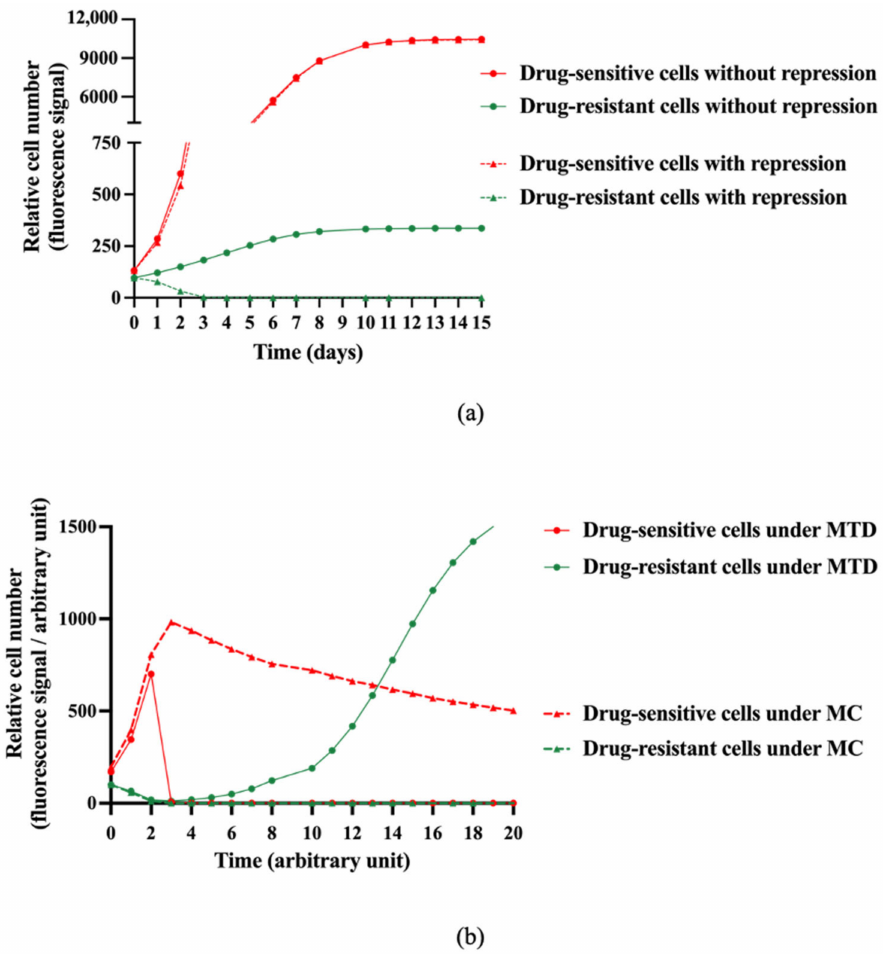
Figure 2. Model-based in silico simulation of the interaction between sensitive and resistant clones with or without treatment. ( a ) Model-based in silico simulations of relative drug-sensitive and drug-resistant cell proliferation over time with or without a repressive effect exerted by the drug- sensitive cells over the drug-resistant ones. ( b ) In silico simulations of relative drug-sensitive and drug-resistant cell proliferation under MTD (Maximum Tolerated Dose) and MC (Metronomic Chemotherapy) schedules and taking into account the suppressive effect of the drug-sensitive cells over the drug-resistant ones ( β > 0 in the